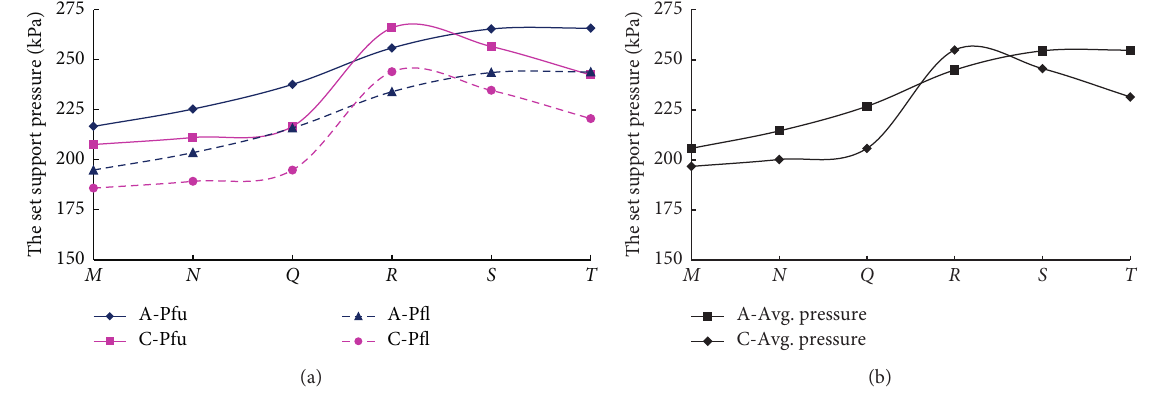
Figure 6: Slurry pressure curves for points A and C in regions 1 and